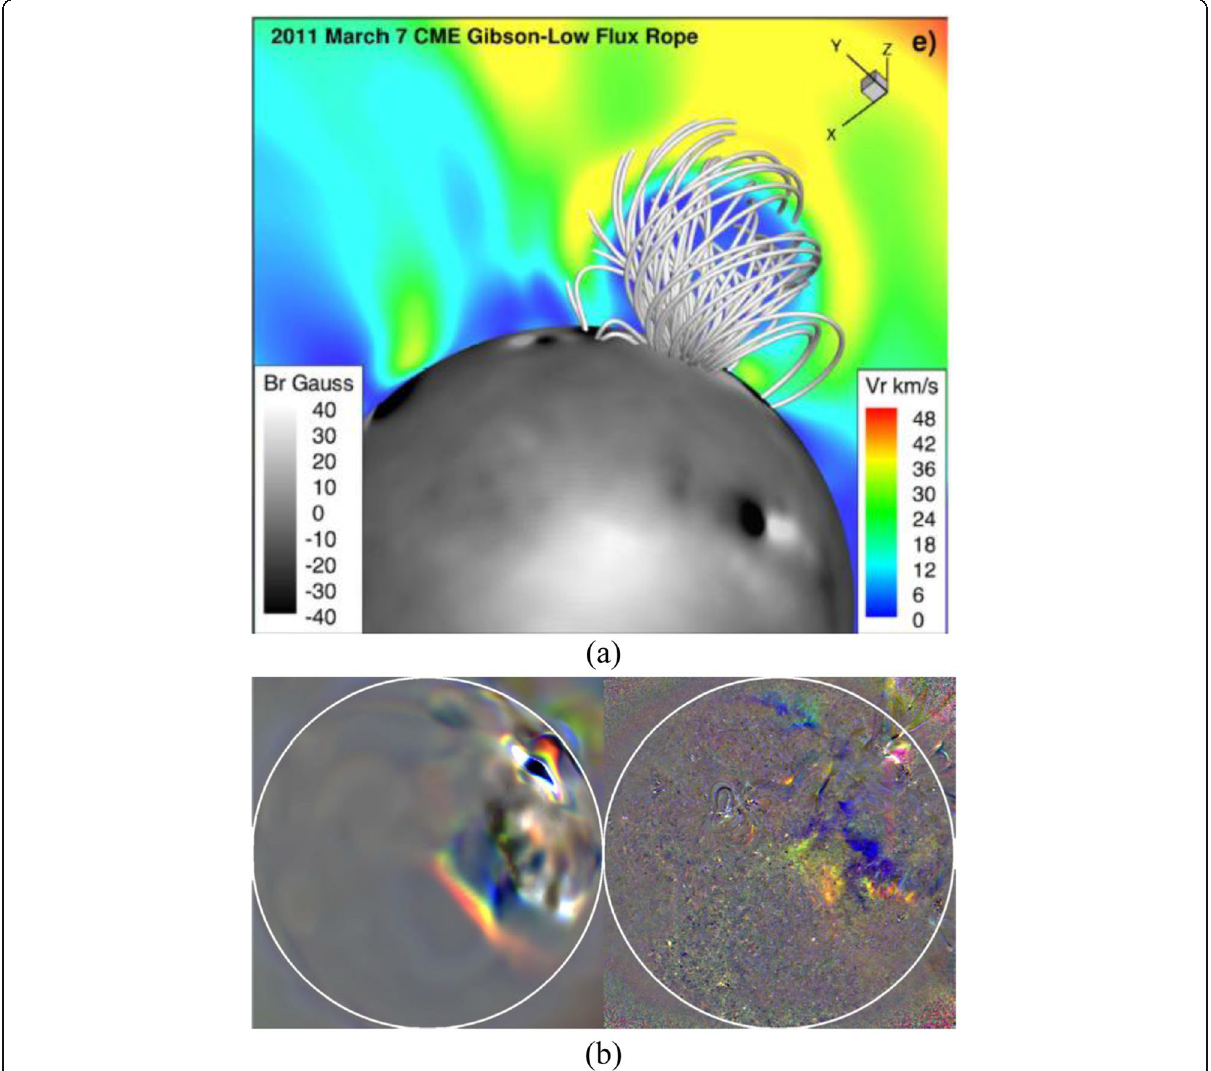
Fig. 14 a Initial GL flux rope configuration for 7 March 2011 CME; b EUV waves in the simulation (left) and in the SDO/AIA observation (right) (From Jin et al.